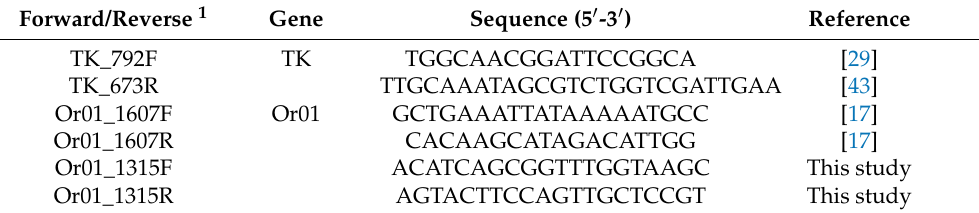
Table A1. List of primers used to prepare standard curve for ILTV and ORT.